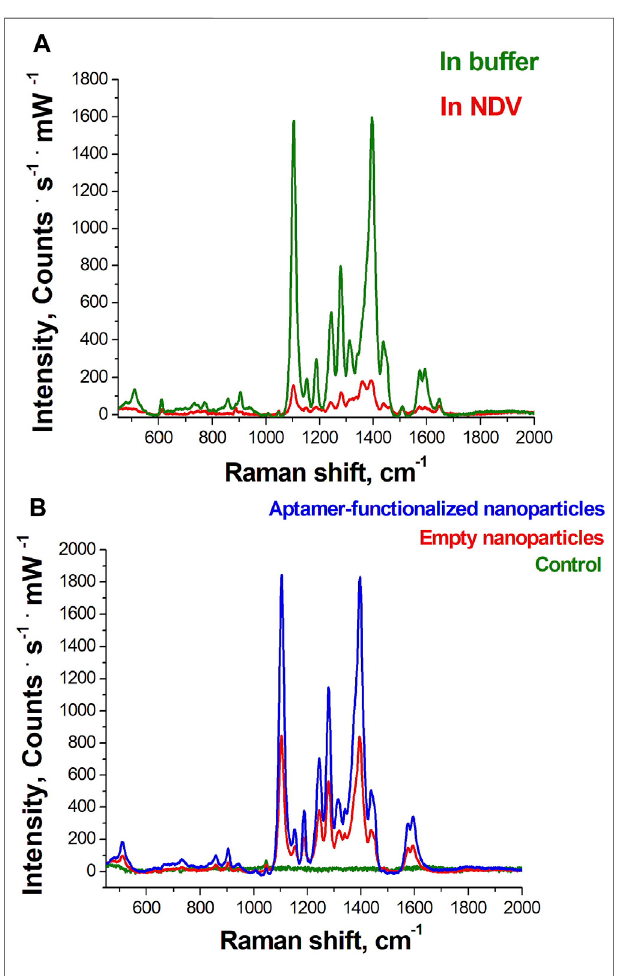
FIGURE6| SERSspectrafromtheBHQ-2amineintheconcentrationof 8 nM: (A) on aggregated aptamer-functionalized silver nanoparticles in buffer C and in the presence of the Newcastle disease virus (NDV, 10 11 VP/ml in allantoic fl uid); (B) on aggregated silver nanoparticles and aggregated aptamer-functionalized silver nanoparticles; green line indicates the Raman spectrum of the BHQ-2 amine in the absence of nanoparticles.